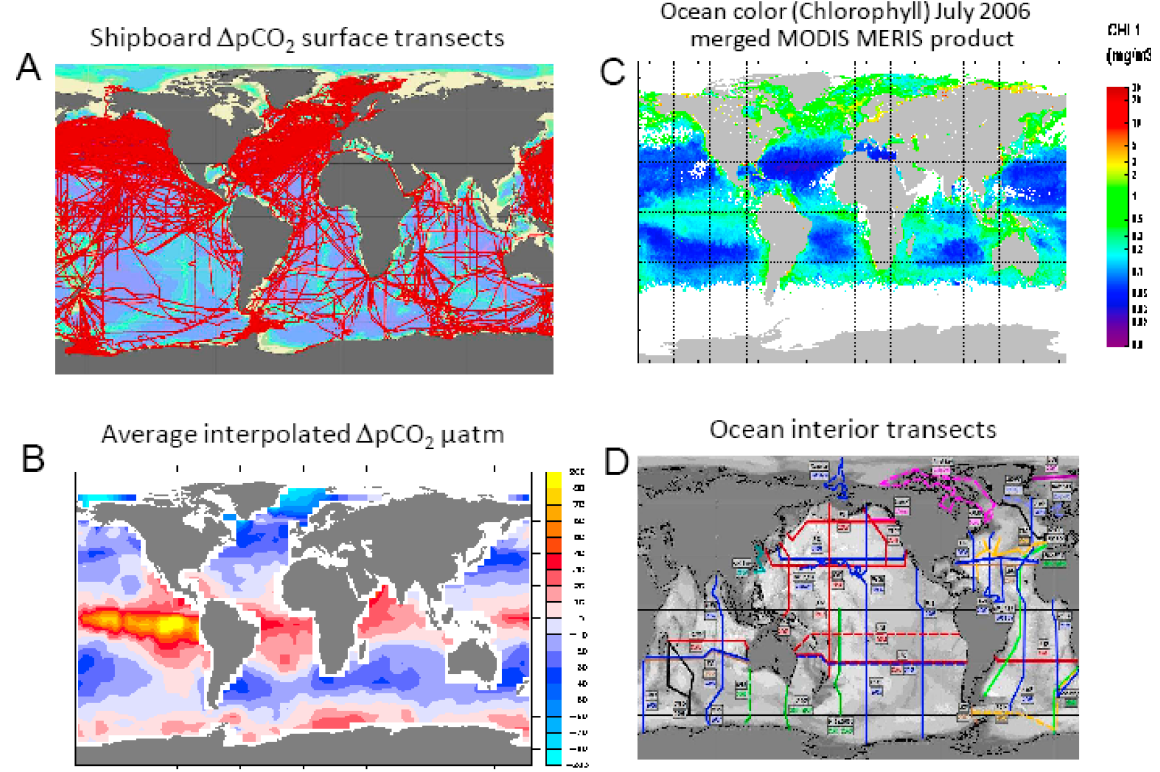
Figure 5. (A) Spatial sampling of surface ocean from research vessels and ships of opportunity observing 1p CO 2 for air–sea flux (from SOCAT). (B) Global 1p CO 2 climatology synthesis obtained from these more than 6 million local measurements (Takahashi et al., 2009). (C) Merged MERIS/MODIS ocean colour product (Chl a ). (D) Transects of main ocean interior measurement campaigns (cross sections from GO-SHIP